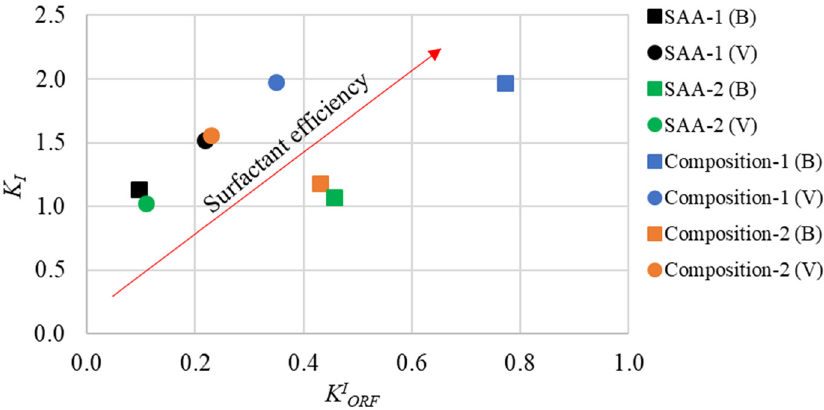
Figure 9. Comparison of the effect of surfactants on injectivity and oil displacement coefficient during spontaneous imbibition ( K IORF ).